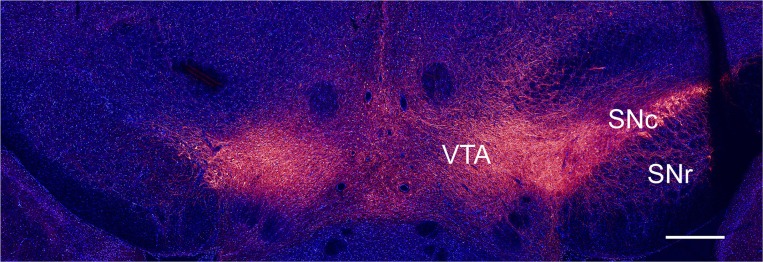
Immunohistochemical verification of unilateral dopamine depletion. Coronal slice from a rat injected with 6-OHDA, immunostained for TH (red) and DAPI (blue), scale bar, 1 mm.